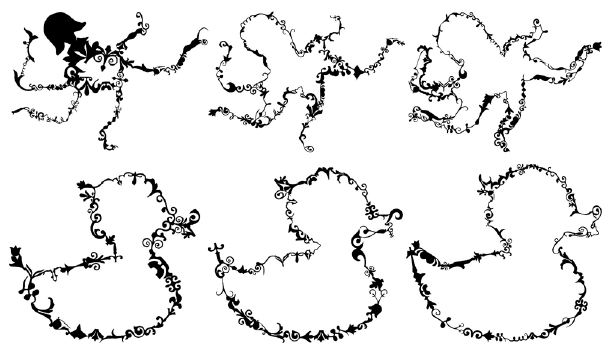
Fig. 9 Left to right: collage results using pipe widths of 0.18, 0.08, and 0.05 (number of patterns m =45).